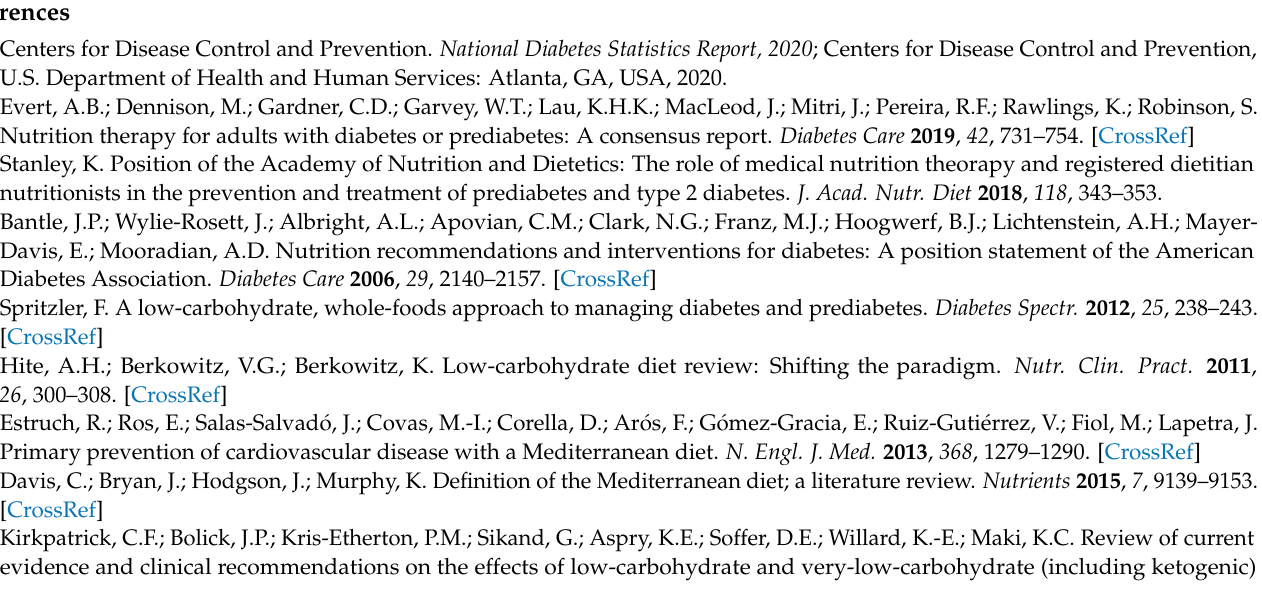
Figure S2: Consort Diagram for the Keto–Med Randomized Trial; Figure S3A–E: Nutrient Data by Randomization Order; Table S4: Comparison of Adherence Scores Within Keto–Med Randomized Trial Diet Phases by Timepoint; Figure S4: Average Blood Ketones Per Week During WFKD Phase; Table S5: Selected Qualitative Responses from Participants about Likes/Dislikes of Study Diets; Figure S5A–C: COVID-19 Related Alterations on Adherence and Physical Activity.